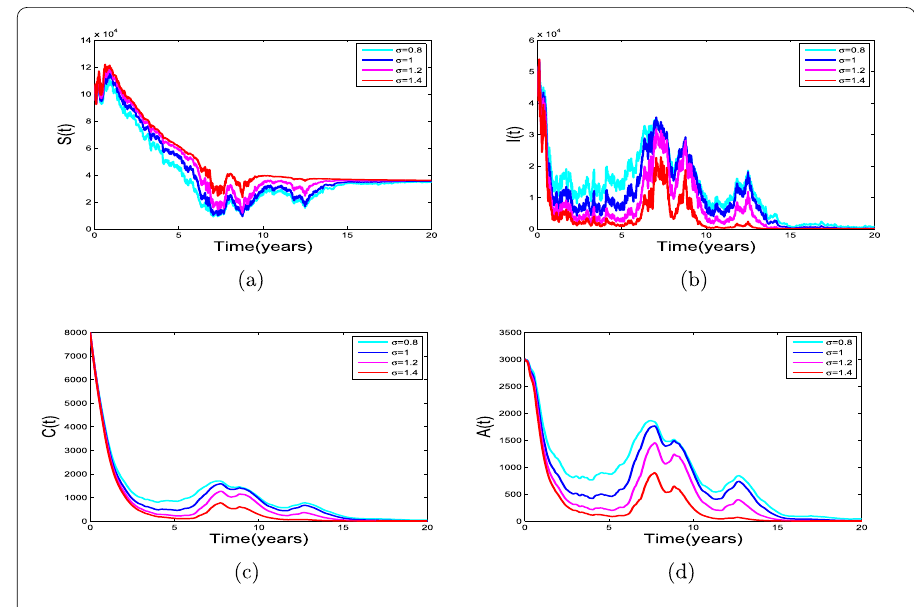
Figure 3 The path of ( S ( t ), I ( t ), C ( t ), A ( t )) for stochastic model (1.2) when σ = 0.8,1,1.2,1.4